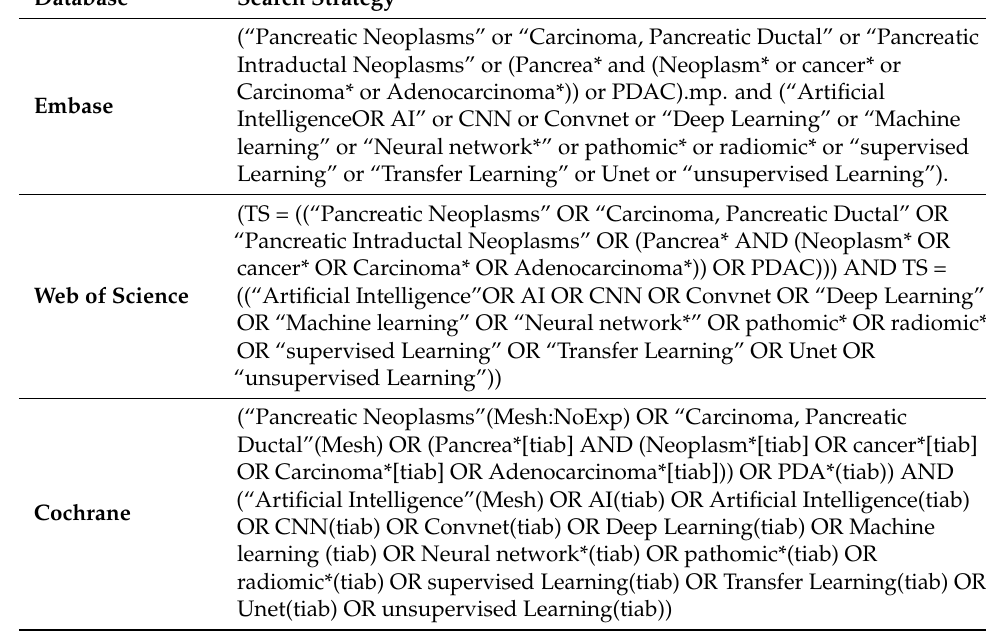
Table A1. Cont. Database Search